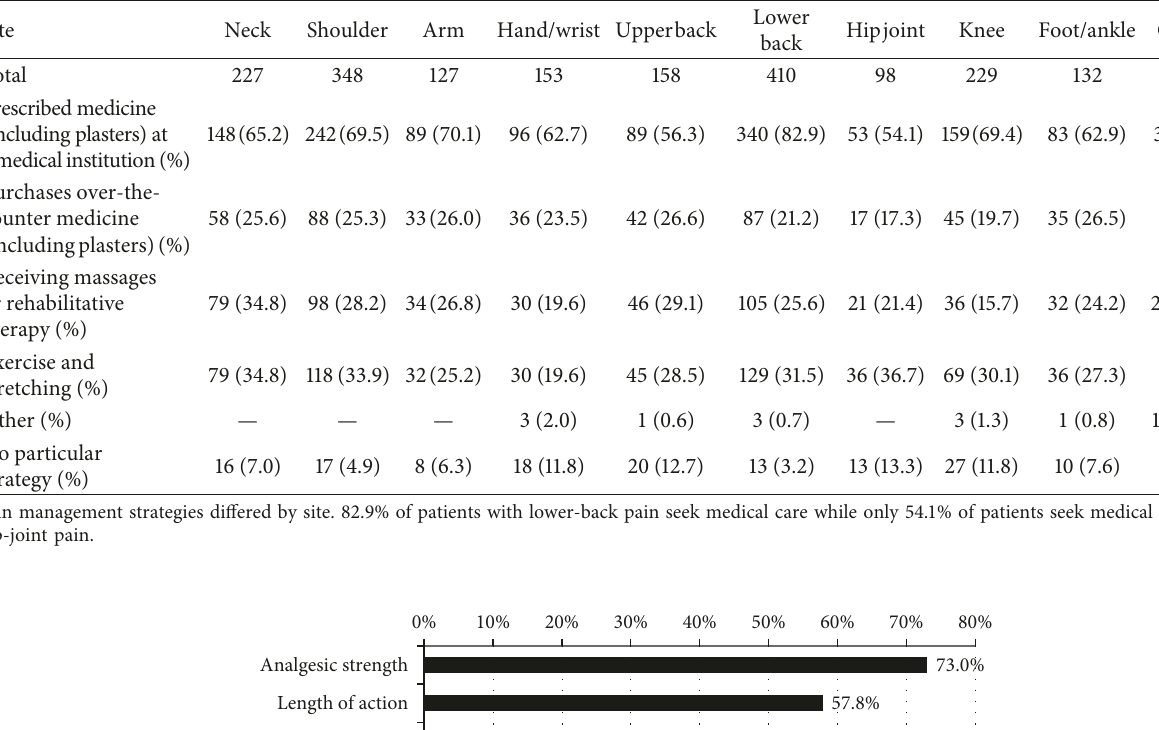
Table 3: Patient survey: pain management strategy by pain site (multiple responses allowed).